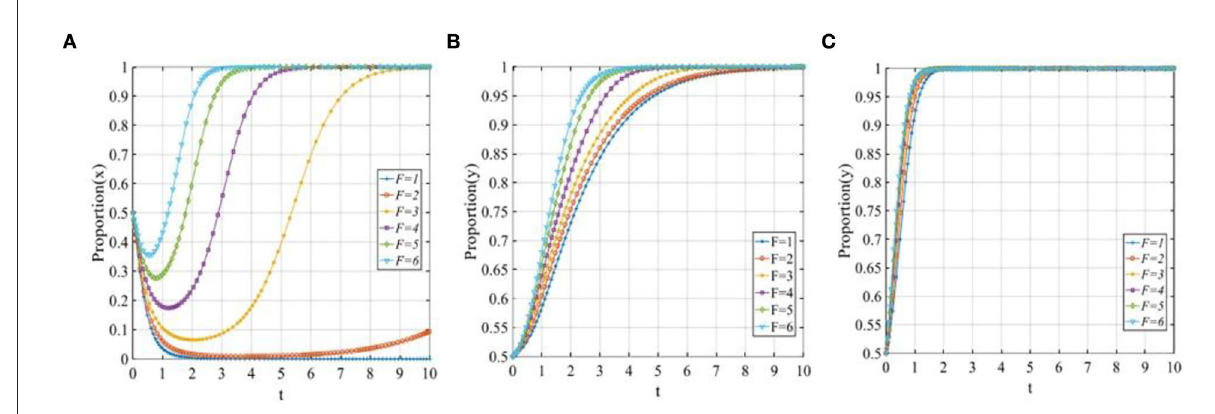
FIGURE8 The sensitivity analysis of the penalty of financial regulators to P2P lending platforms when F = 1, 2, 3, 4, 5, 6. (A) The sensitivity of P2P lending platforms; (B) The sensitivity of investors; and (C) The sensitivity of financial regulators.